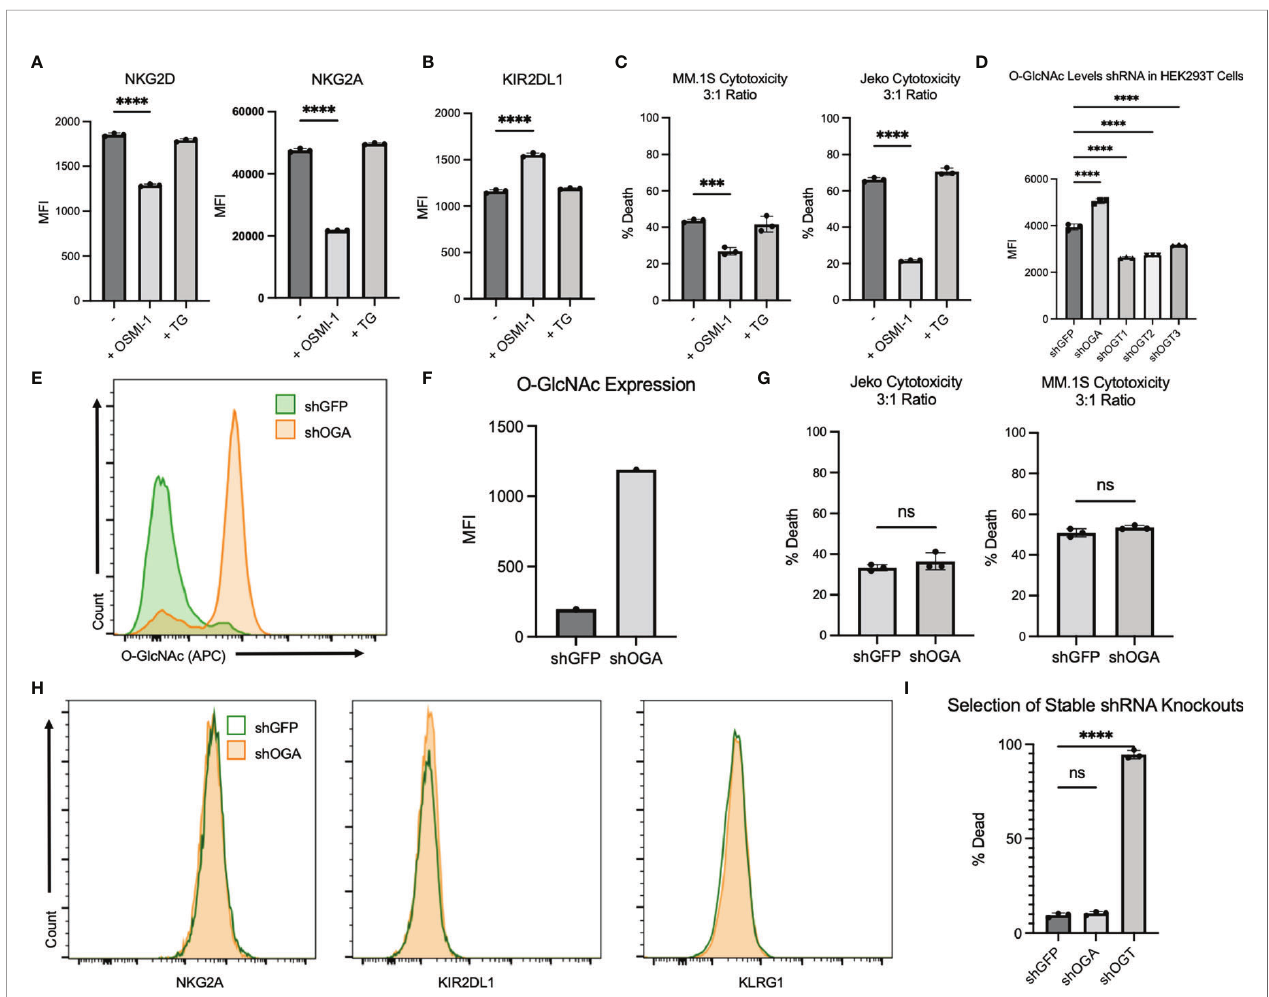
FIGURE 4 | NK92 cells display a similar phenotype to that of primary NK cells after OSMI-1 (25 µM) and TG (50 µM) treatment. Stable shOGA generation in NK92s displays similar results to TG-treated NK92s. (A) Two prominent receptors for cytotoxic function after 24 h of treatment with OSMI-1 (25 µM) or TG (50 µM) displayed as MFI representations of fl ow analysis. (B) KIR2DL1 displayed as MFI representation of fl ow cytometry analysis from the same experimental design as (A) . (C, G) NK92 (C) and shGFP/shOGA (G) cytotoxicity displayed as % Death (PI-positive cells detected on PE channel) on fl ow cytometry using the same gating strategy and design as Figure 3A against Jeko and MM.1S cells at 3:1 NK-to-target ratio. (D) Intracellular O-GlcNAc levels shown on fl ow cytometry 30 h post transfection in HEK293T cells. (E) Displays intracellular O-GlcNAc expression via fl ow cytometry of shOGA stable knockdown vs. shGFP control. (F) Graphical representation of fl ow cytometry shown in panel (E) . (H) Prominent receptors of NK cell cytotoxicity displayed in shGFP vs. shOGA cells 10 days after puromycin selection was completed. (I) Displays data showing cell death based on PI staining on fl ow cytometry for shGFP, shOGA, and shOGT after transduction 6 days after puromycin (2 µg/ml) selection has begun. Statistical analysis for receptors and NK92 cytotoxicity determined via one-way ANOVA with Dunnett ’ s multiple comparisons to the NK group mean. Signi fi cance for shGFP vs. shOGA cytotoxicity determined by unpaired Student ’ s T-test. NS indicates no signi fi cance. *** indicates signi fi cance of p <.001 and **** indicates p <.0001. Error bars are standard deviation of the mean. Experiments 4A – C were performed three times. Experiments 4D – I were performed twice. The three individual values displayed are cell cultures within one experiment, and experiments displayed are representative of all experimental results of